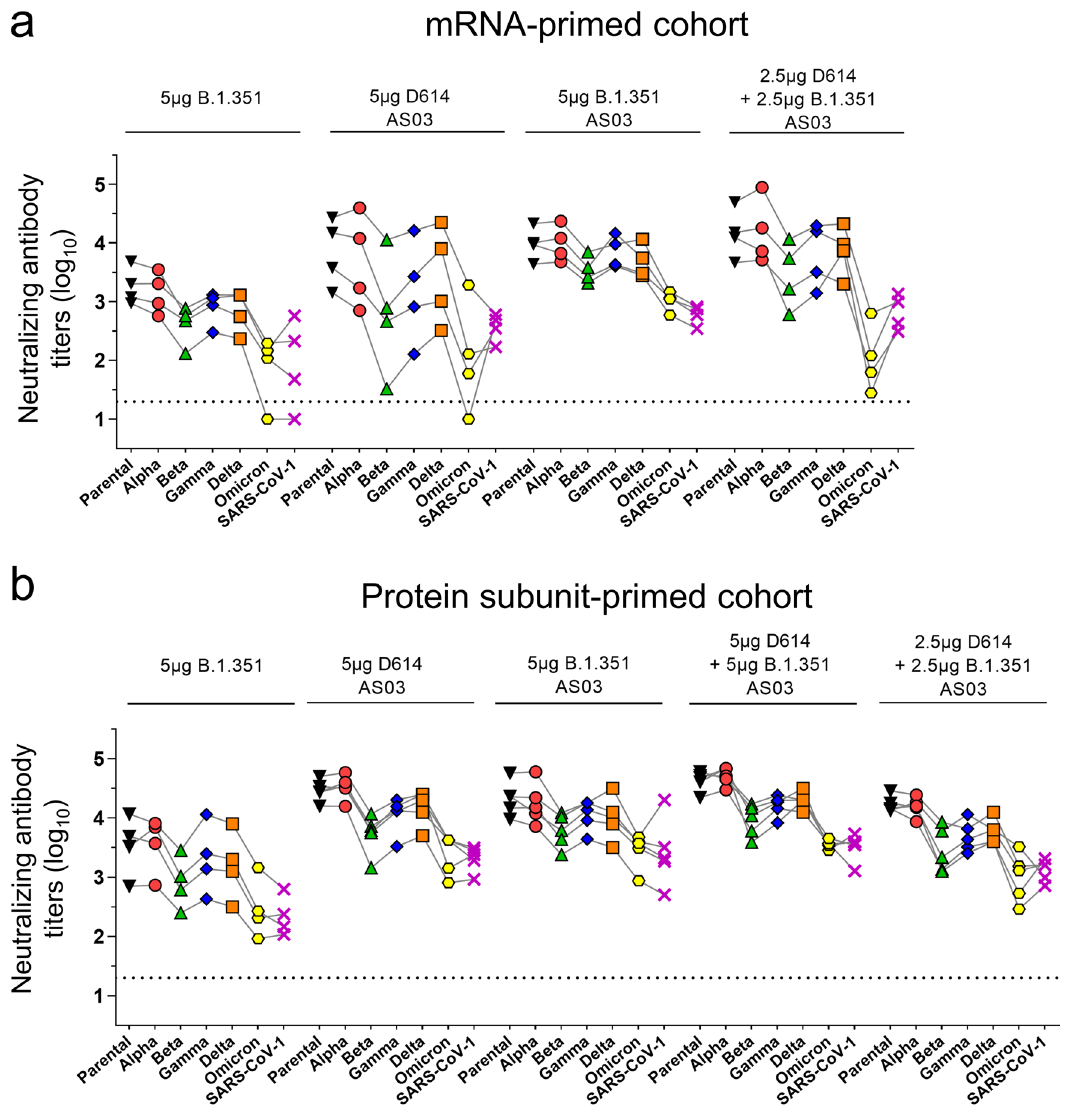
Fig. 2 Booster cross-neutralizing antibody responses against the current VOC and SARS-CoV-1 in the mRNA- and subunit-primed macaques. Pseudovirus-neutralizing antibody assays against the parental SARS-CoV-2, variants of concern (Alpha, Beta, Gamma, Delta, and Omicron), and SARS- CoV-1 was assessed at day 14 after the booster injection in primed-macaques a mRNA-primed cohort ( n = 4/group) and b protein subunit-primed cohort ( n = 4 or 5/group). Individual macaque data are shown and are linked by connecting lines. Horizontal dotted lines indicate the limits of quanti fi cation of the